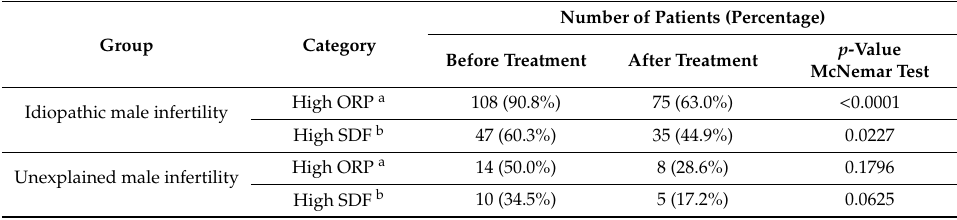
Table 7. E ff ect of FH PRO for Men on seminal ORP and SDF in men with idiopathic male infertility and unexplained male